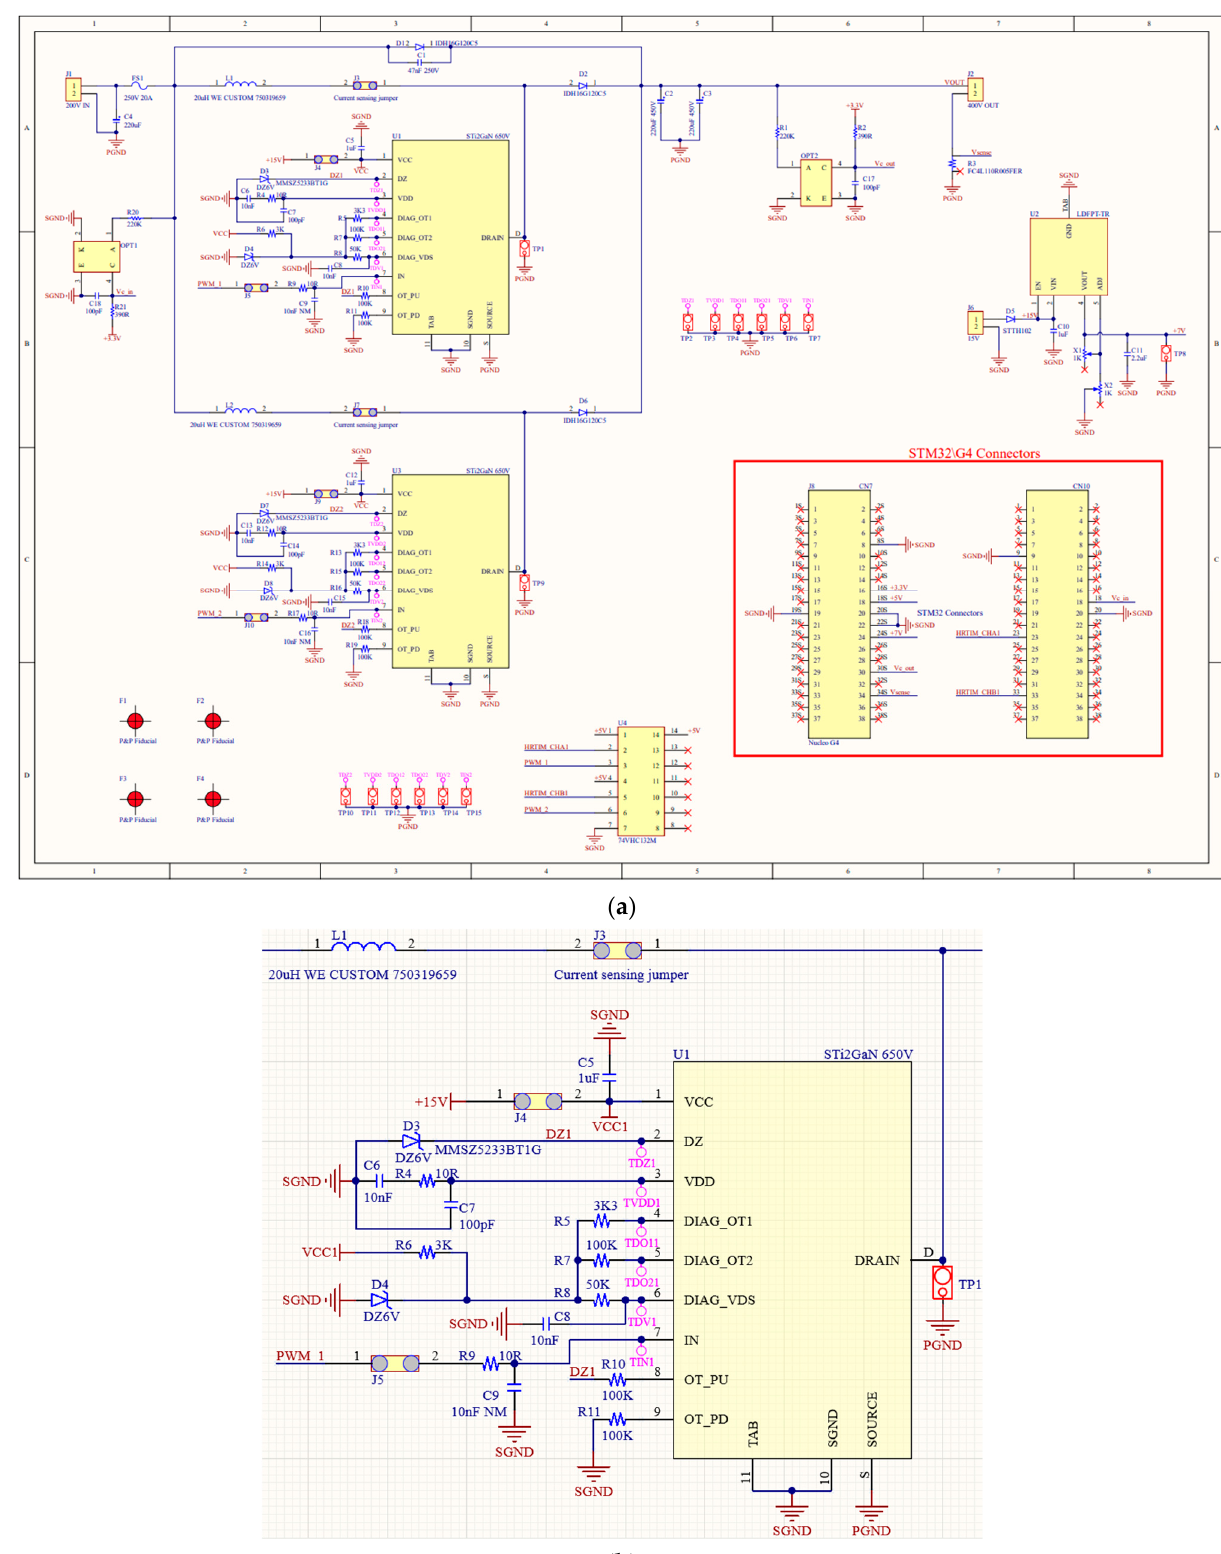
Figure 22. Interleaved boost converter PFC: ( a ) schematic; ( b ) detail of the implementation of the power devices.